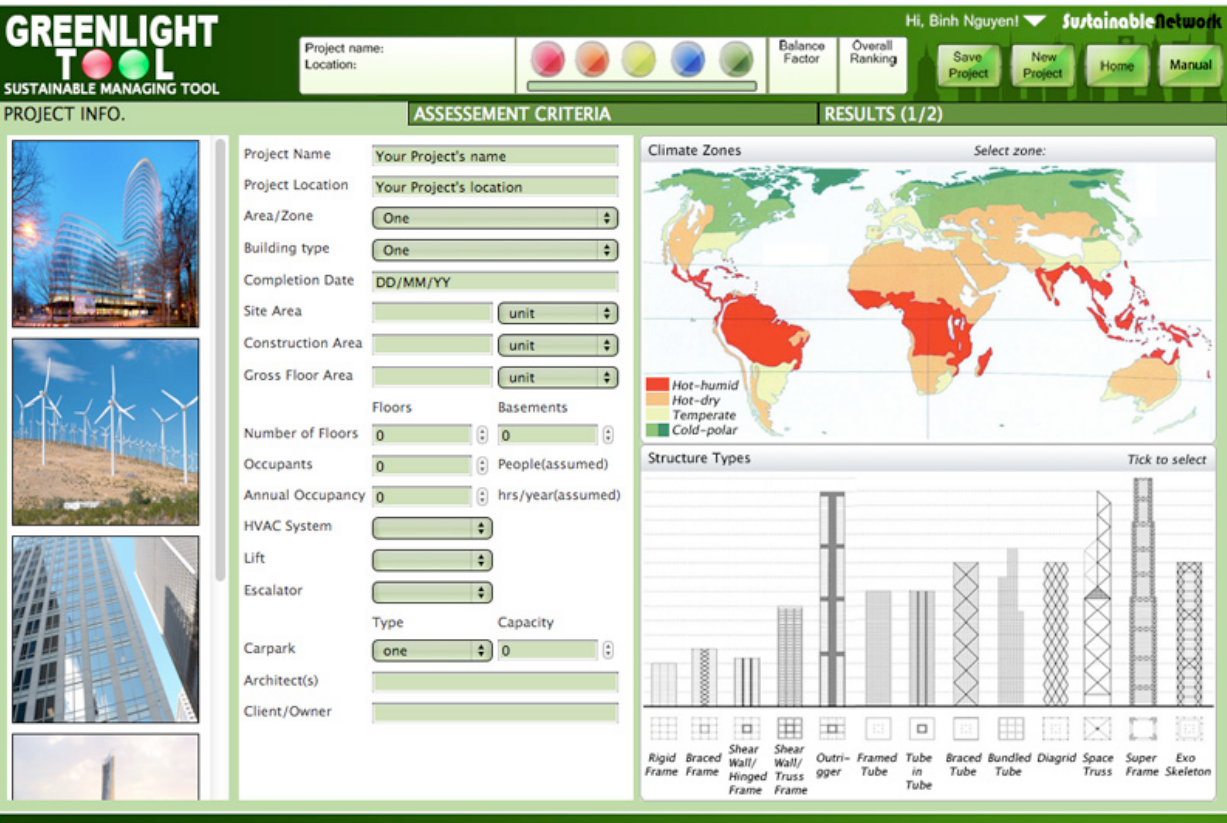
Figure 7. GreenLight